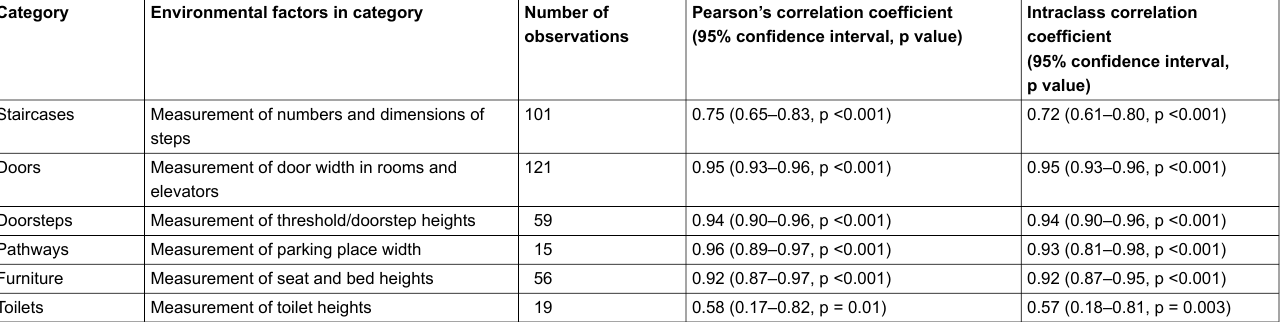
Pearson’s correlation coefficient observations (95% confidence interval, p value)